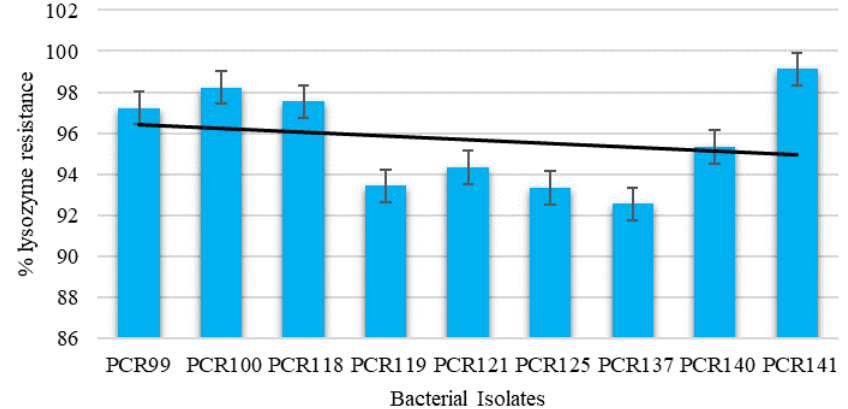
Figure 5. Determination of cell viability of bacterial isolates against Lysozyme resistance. Values are means of replicate experiments; ± indicates standard deviation from the mean. Values differ significantly ( p < 0.05).